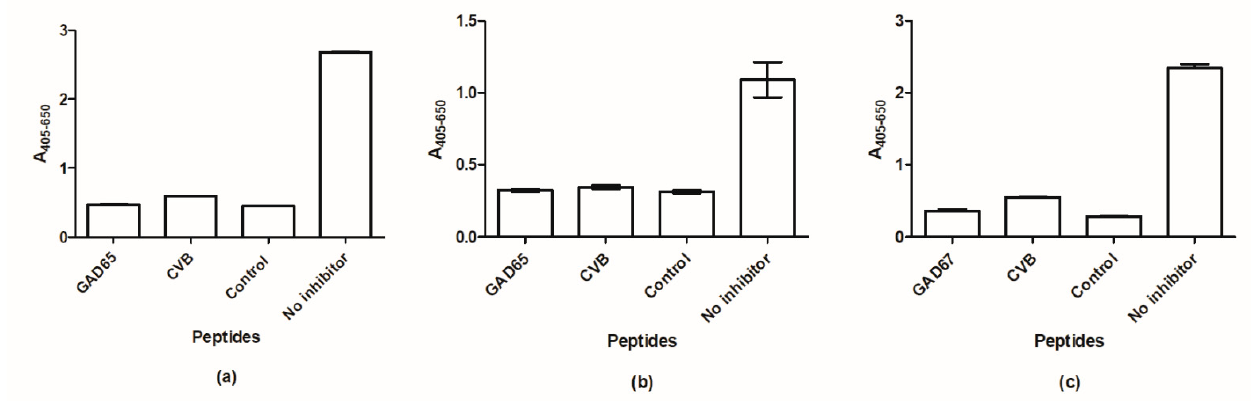
Figure 11. Reactivity of SSI-HYB 386-01, SSI-HYB 386-02, and SSI-HYB 387-02 analyzed by competitive inhibition assays. ( a ) Reactivity of SSI-HYB 386-01 to glutamic acid decarboxylase (GAD65). ( b ) Reactivity of SSI-HYB 386-02 to GAD65. ( c ) Reactivity of SSI-HYB 387-02 to GAD67. Inhibiting peptides; GAD65/67, CVB, control peptide (GQGRGRWRGRGRSKGRGRMH).